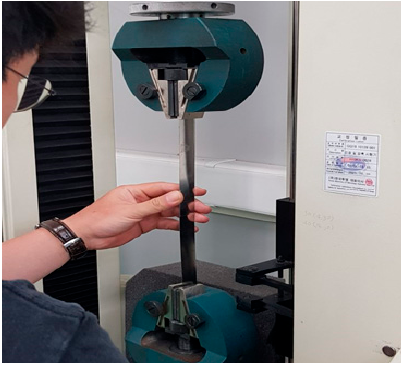
Figure 7. The tensile speed was fixed at 5 mm/min.